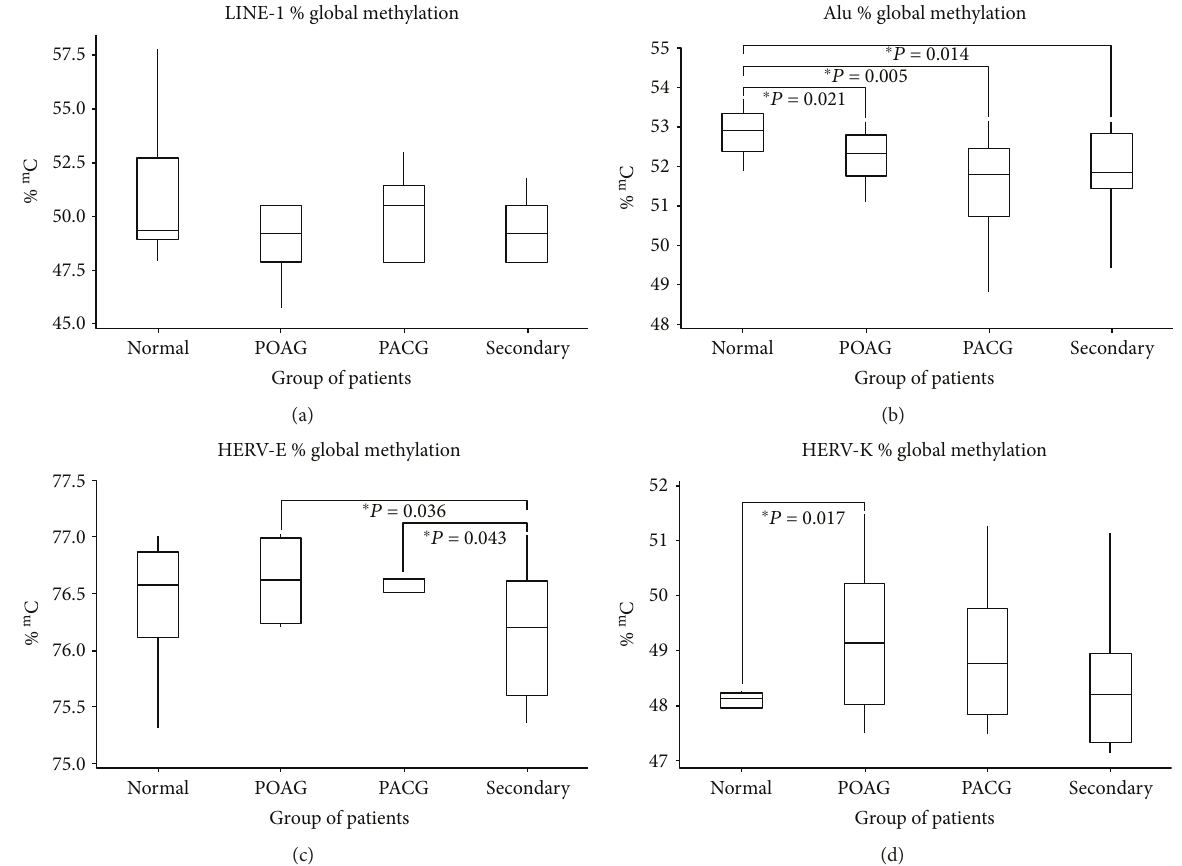
Figure 4: Box plots showing methylation percentage: (a) LINE-1 methylation analysis, (b) Alu methylation analysis, (c) HERV-E methylation analysis, and (d) HERV-K methylation analysis. POAG=primary open-angle glaucoma; PACG =primary angle-closure glaucoma; secondary=secondary glaucoma; % m C=percentage of methylation. ∗ represents a signi fi cant di ff erence at p < 0 05 by Wilcoxon rank-sum